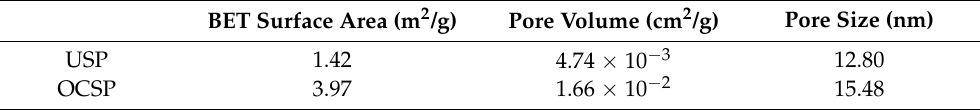
Figure 6. N 2 adsorption–desorption isotherms and pore size distributions of ( a ) USP and ( b ) OCSP. Table 1. Specific surface area, pore volume, and pore size of USP and